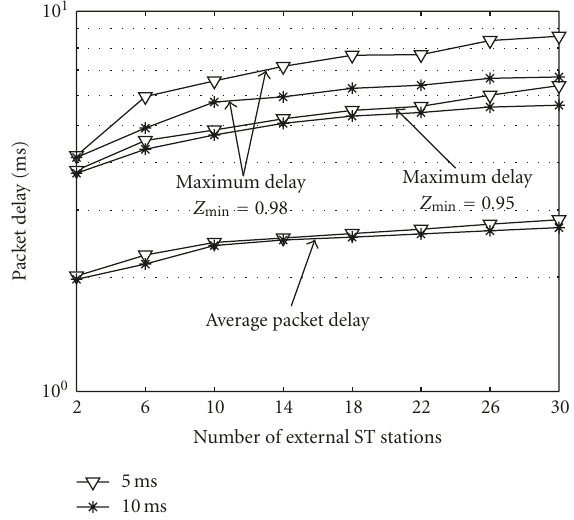
Figure 10: Packet delay—MSP = 5ms and 10